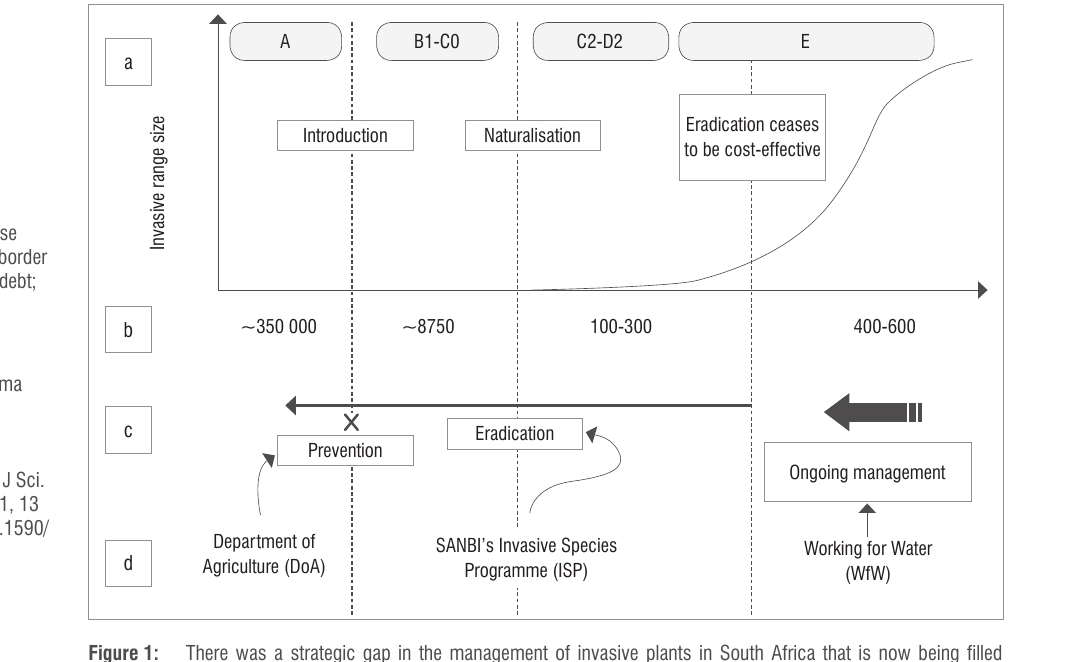
Figure 1: There was a strategic gap in the management of invasive plants in South Africa that is now being filled by the South African National Biodiversity Institute's Invasive Species Programme. Schematic of the progression of an invasion with relevant categories (a), 5 estimates of the number of plant species in South Africa recorded in each group (b), the three major strategies for dealing with biological invasions (c) and the organisations responsible for managing alien plants at each stage